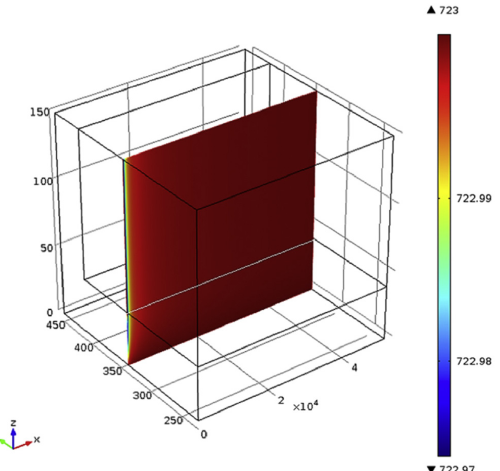
Figure 6. Temperature distribution on the x-z plane of the microchannel reactor at T = 723 K and NH 3 flow rate = 500 Nml min − 1 [6].